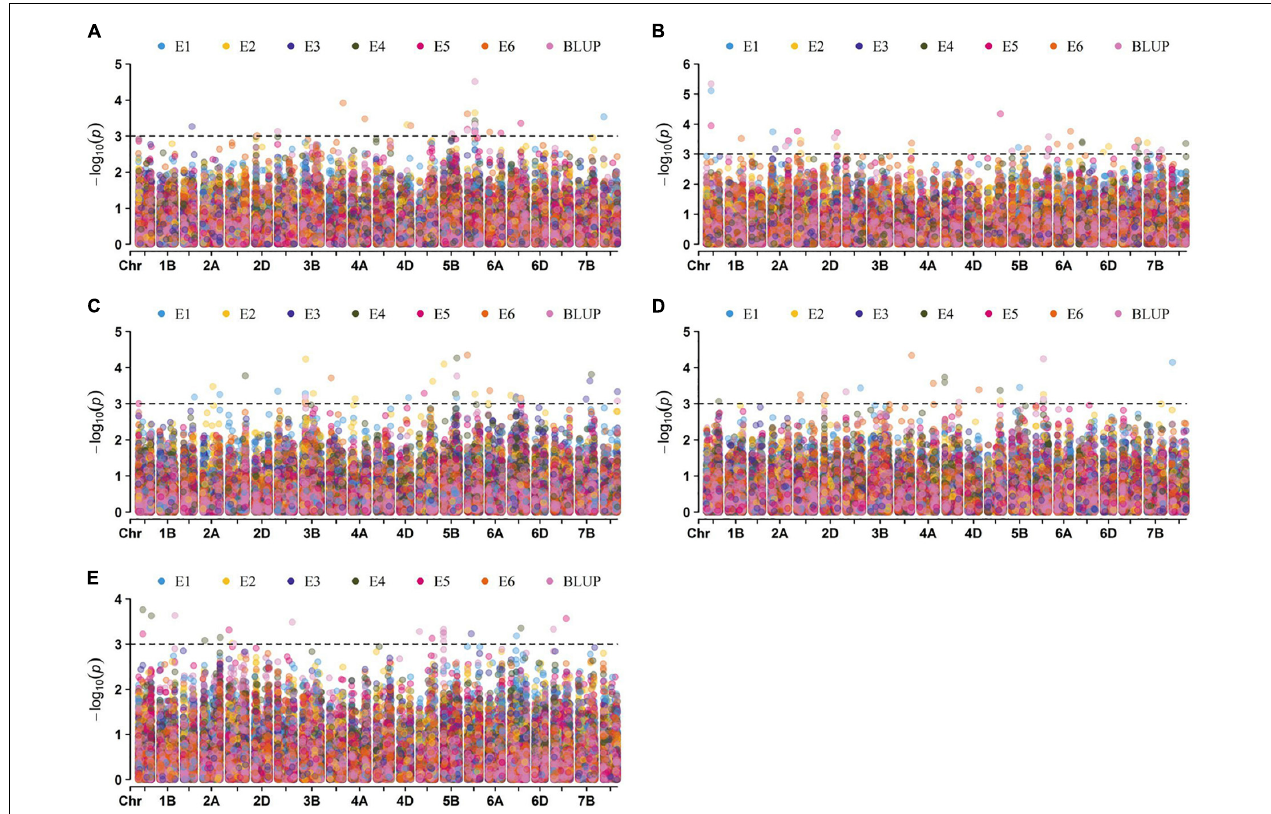
FIGURE 4 | Manhattan plots for the kernel traits. The association of 13228 SNPs located on 21 chromosomes in six environments and BLUP for KL, KW, KDR, KP, and TKW were shown in panels (A–E) , respectively. Dotted lines indicate the threshold value at –log 10 ( P ) =